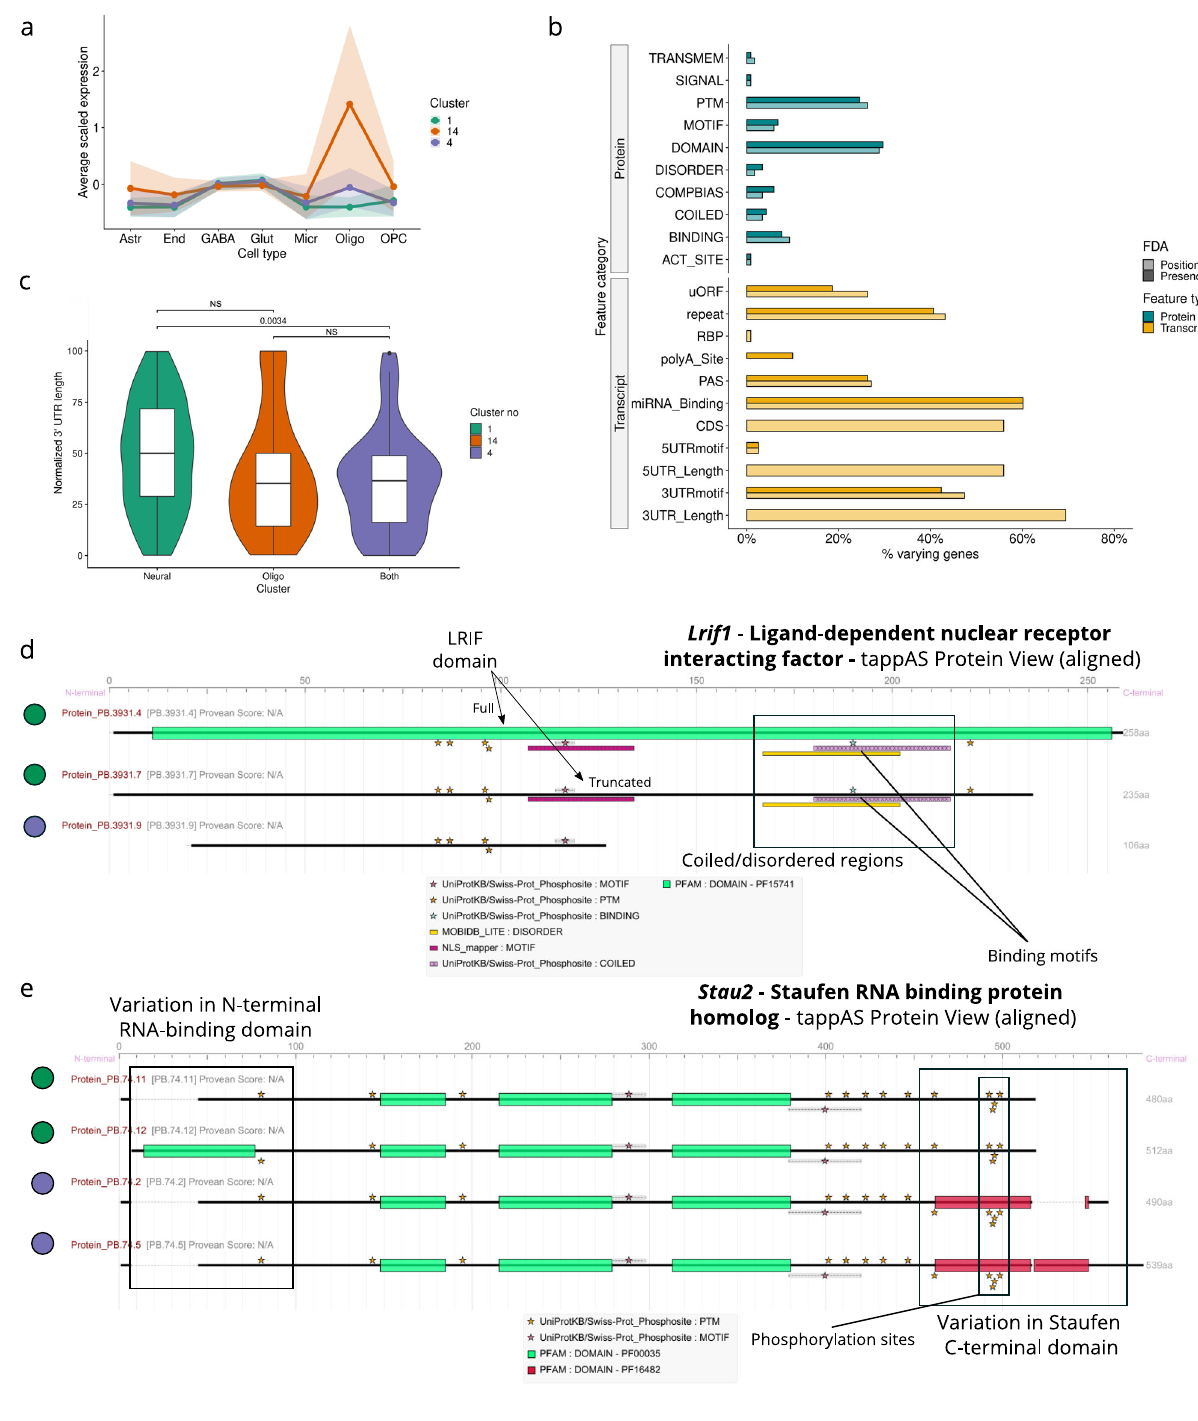
Fig. 6 Functional analysis of the 118 coDIU genes detected across neural-oligodendrocyte clusters (no. 1, 4, and 14). a Cell type expression patterns of clusters selected for downstream functional analysis: neural (cluster 1, green), oligodendrocyte (cluster 14, orange) or shared (cluster 4, purple). For each cluster, cell-level mean expression (scaled) is computed for all transcripts, and cell means are aggregated to obtain a global cell type mean, represented by the lines. Colored areas correspond to cell type mean ± standard deviation. b Functional Diversity Analysis (FDA) results. y -axis: functional annotation categories. x -axis: percentage of genes including at least one varying feature from a given functional category. c Violin and boxplots of normalized 3 ′ UTR lengths for isoforms in each of the three neural-oligodendrocyte clusters ( n = 177 transcript isoforms from coDIU genes with 3 ′ UTR variability). Normalized lengths are computed by dividing each individual isoform ’ s 3 ′ UTR length by the sum of 3 ′ UTR lengths of all the gene ’ s isoforms. Violin plots indicate density distributions. For boxplots, boxes indicate median (middle line), 25th (Q1) and 75th (Q3) percentiles (box hinges); whiskers represent min = Q1 − 1.5 · Interquartile Range (IQR) and max = Q3 + 1.5 · IQR; dots constitute outliers. Signi fi cance levels for the comparison of the three groups are indicated above the corresponding braces ( p- value, Wilcoxon ’ s test, two-sided). NS: not signi fi cant. tappAS view of d Lrif1 and e Stau2 protein annotations. Cluster assignments for each isoform are indicated by dot